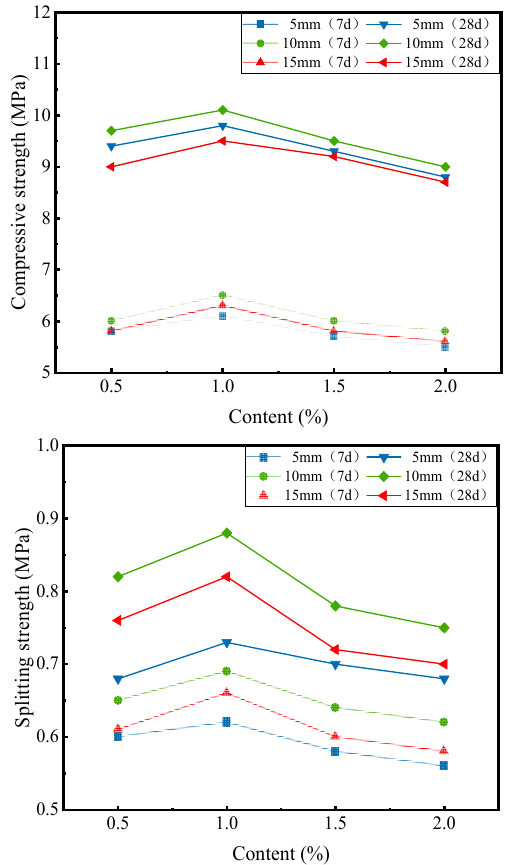
Figure 5. Relationship between the fiber content, length, and mechanical strength of cement-stabilized macadam.